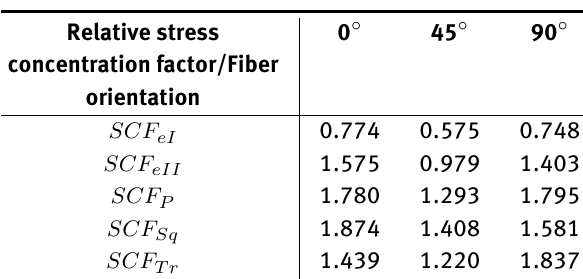
Shape of hole : Table 7 shows the relative stress concen- tration factors for different shapes of hole and fiber orien- tations with respect to the circular hole shape having 0 ∘ fiber orientation. Relative stress concentration factors for different hole shapes are denoted as given here: